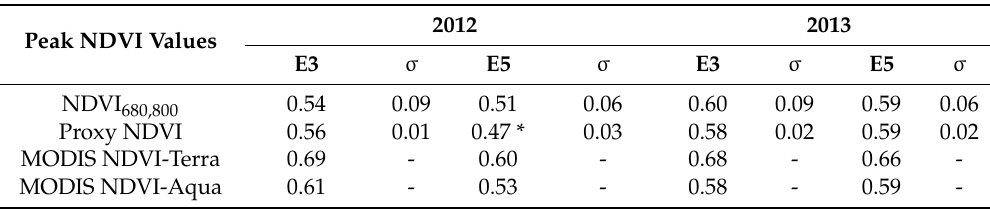
Table 1. Peak NDVI values and standard deviation ( σ ) in 2012 and 2013 for both sites (E3 and E5), satellite (AQUA and TERRA sensors). The asterisk (*) indicates an anomalously low peak value due to missing mid-season data (spanning 26 June–27 August